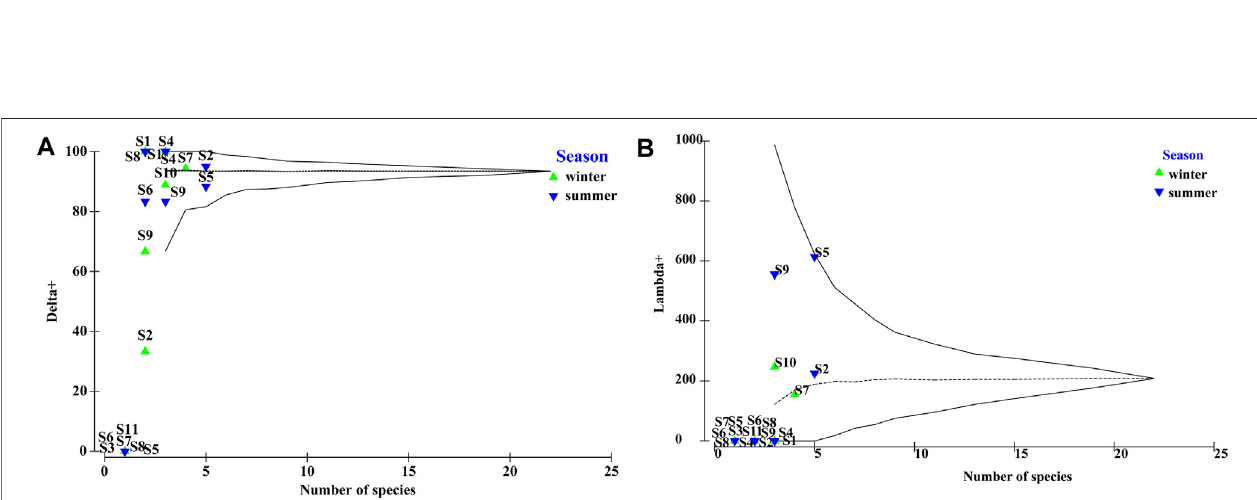
FIGURE 3 | Funnel plots of (A) averages ( Δ + [alpha]), and (B) variations ( Λ + [lambda]) in taxonomic distinctness indices for different sites and seasons.